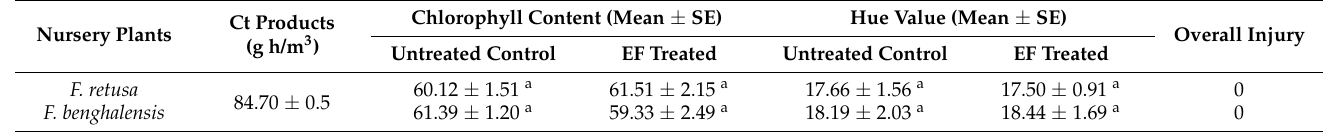
Table 2. Effect of ethyl formate (EF) fumigation (35 g/m 3 for 4 h at 15 ± 1 ◦ C) on leaf chlorophyll content, leaf hue value, and overall plant injury of two species of imported potted rubber plants ( Fiscus retusa and F. benghalensis ) after 30-day postfumigation growth period in a greenhouse. Different letters on means indicate significant differences between EF treatment and untreated control by t -test at p < 0.05.